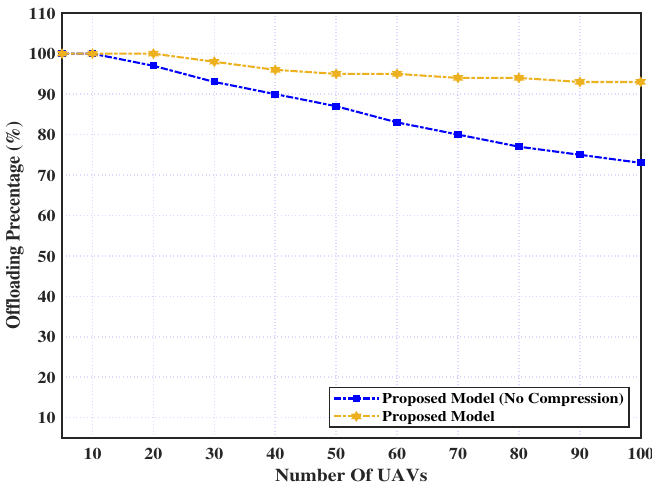
Figure 2. Offloading percentage over number of UAVs.